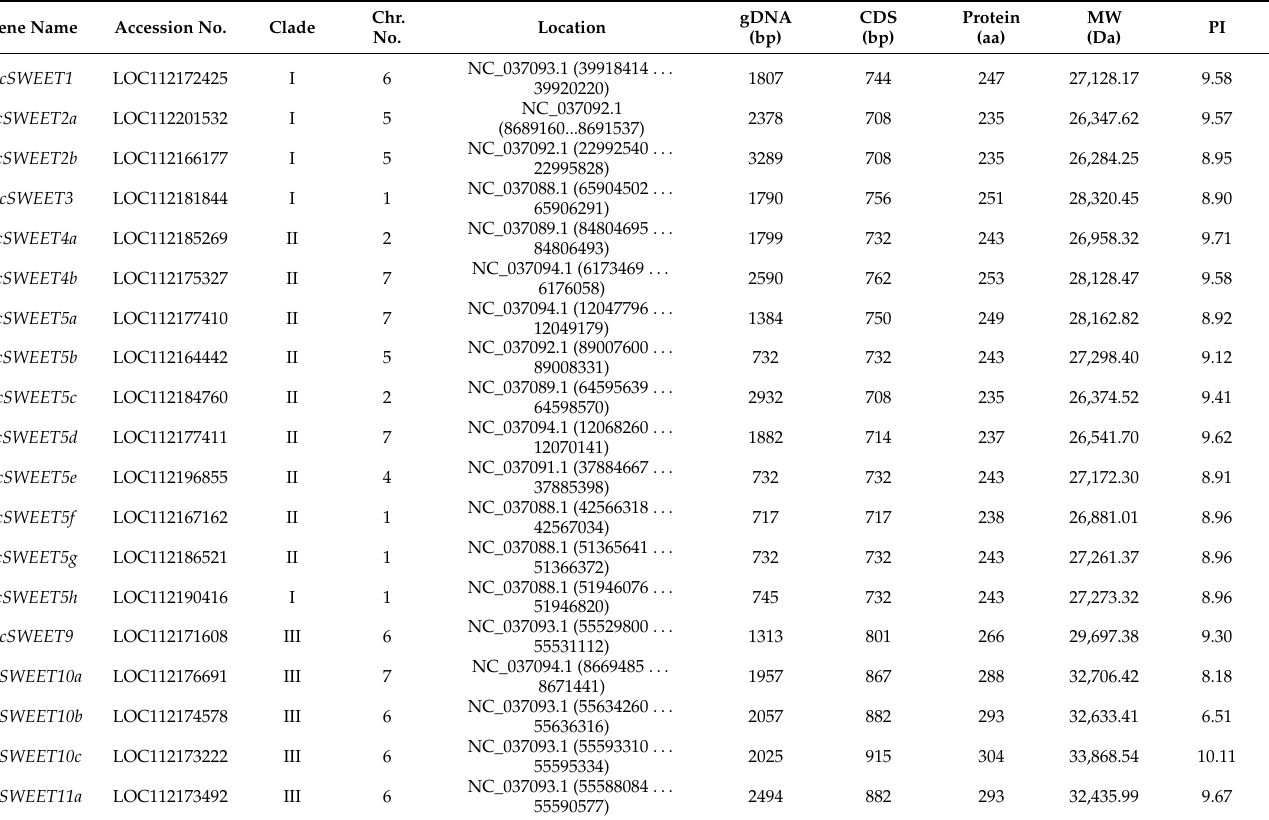
Table 1. Characteristics of the RcSWEET gene family members in R. chinensis ‘Old